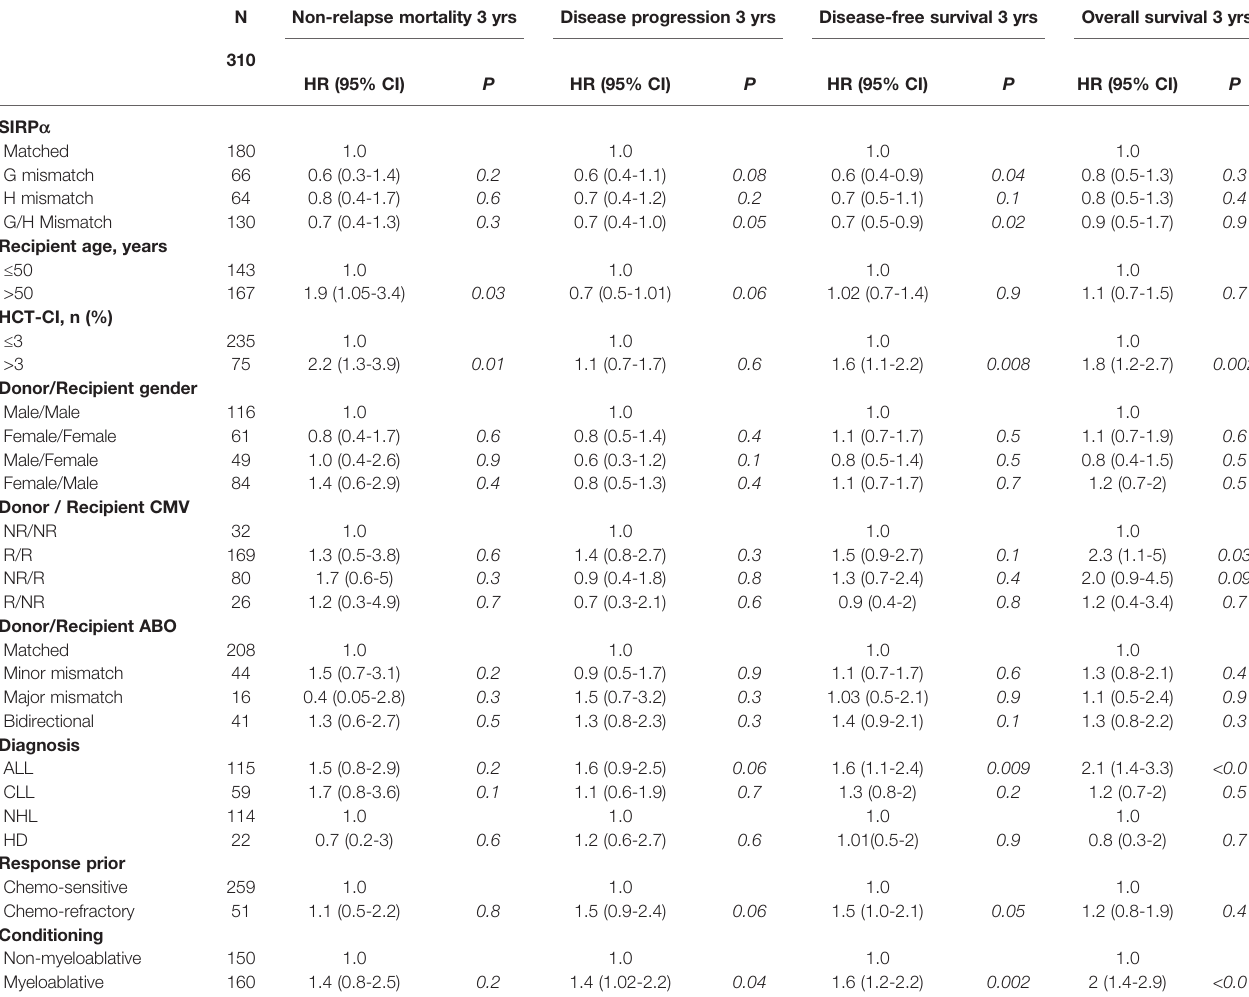
TABLE 4 | Univariable analysis evaluating predictors of non-relapse mortality, disease progression, progression-free survival and overall survival.